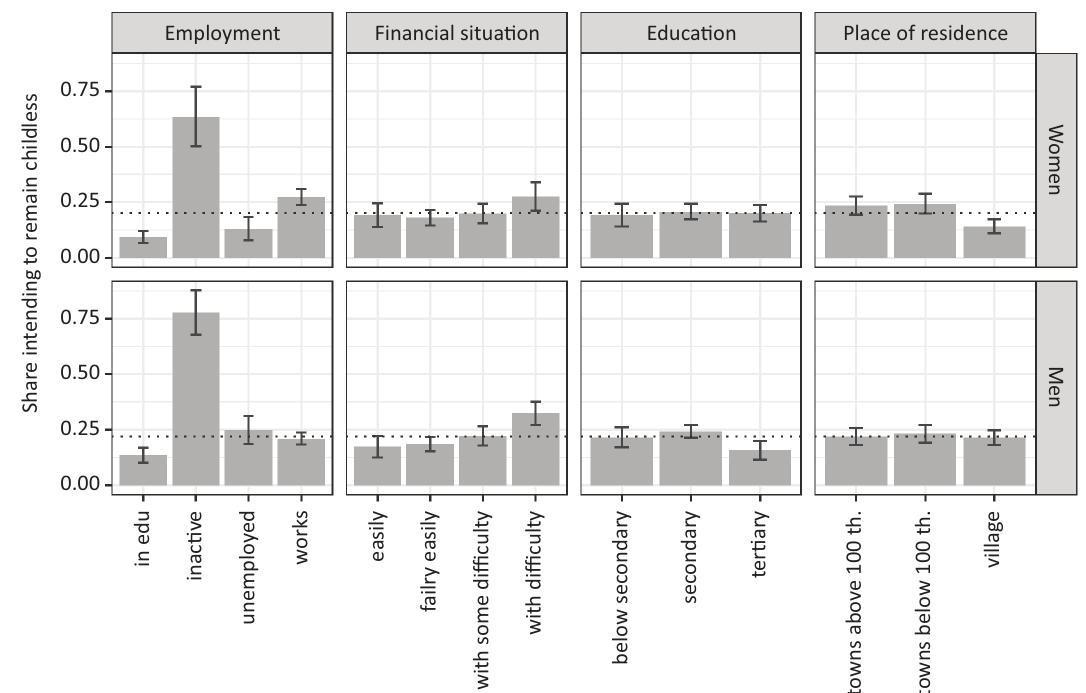
Figure 1. Respondents intending to remain childless, by socioeconomic characteristics and gender, with 95% confidence intervals. Notes: The dotted horizontal lines denote the mean share of women (upper panels) and men (lower panels) intending to remain childless; data weighted with post‐stratification weights. shape the intention to remain childless independently from socioeconomic factors.